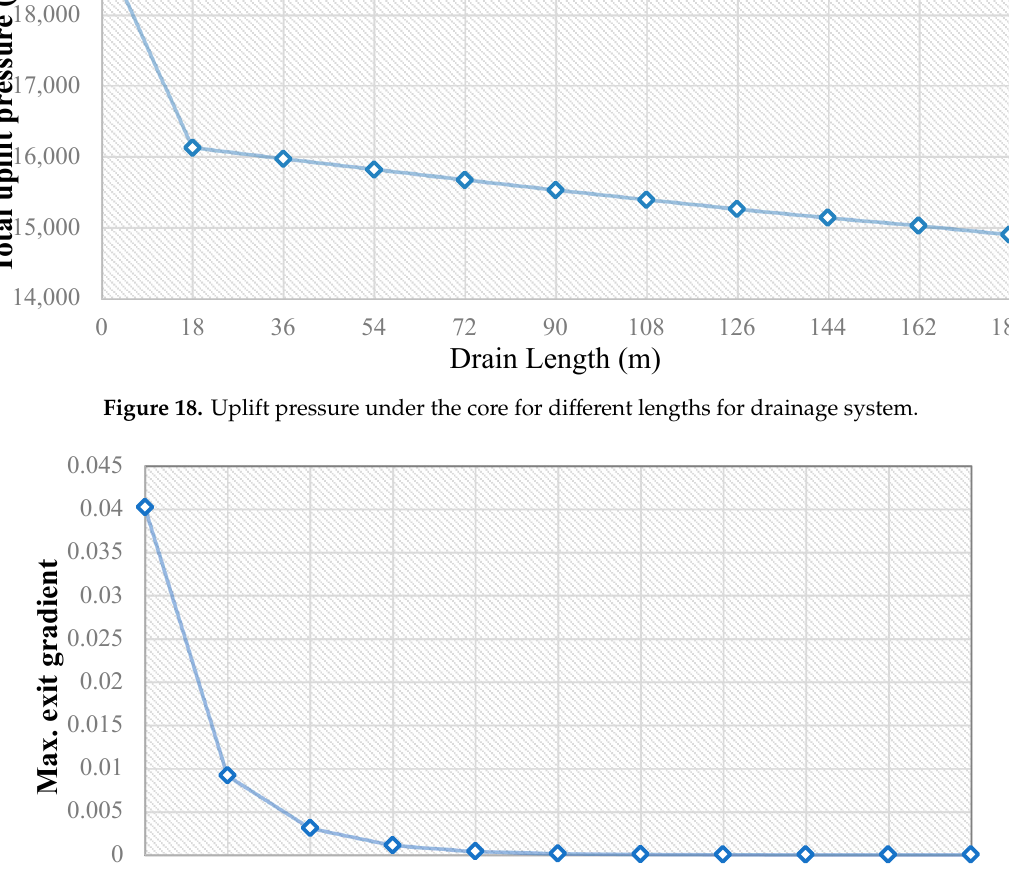
Figure 19. Maximum gradient of outlet discharge for different lengths for drainage system.